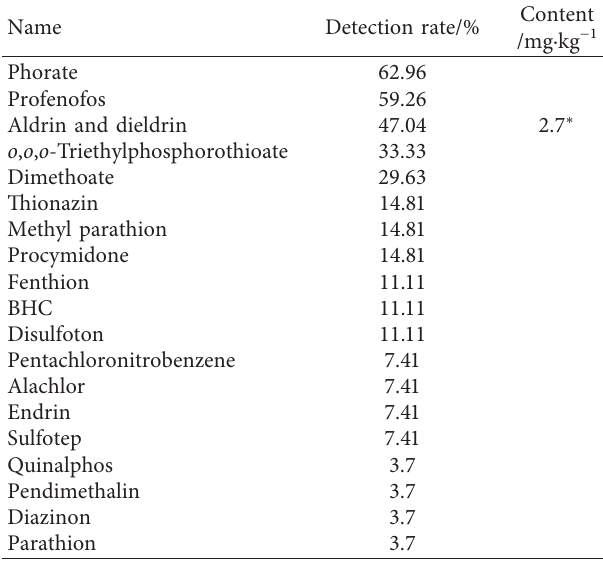
Table 2: Detection rates of pesticides in 27 Chrysanthemum indicum samples ( ∗ indicates that the limit is